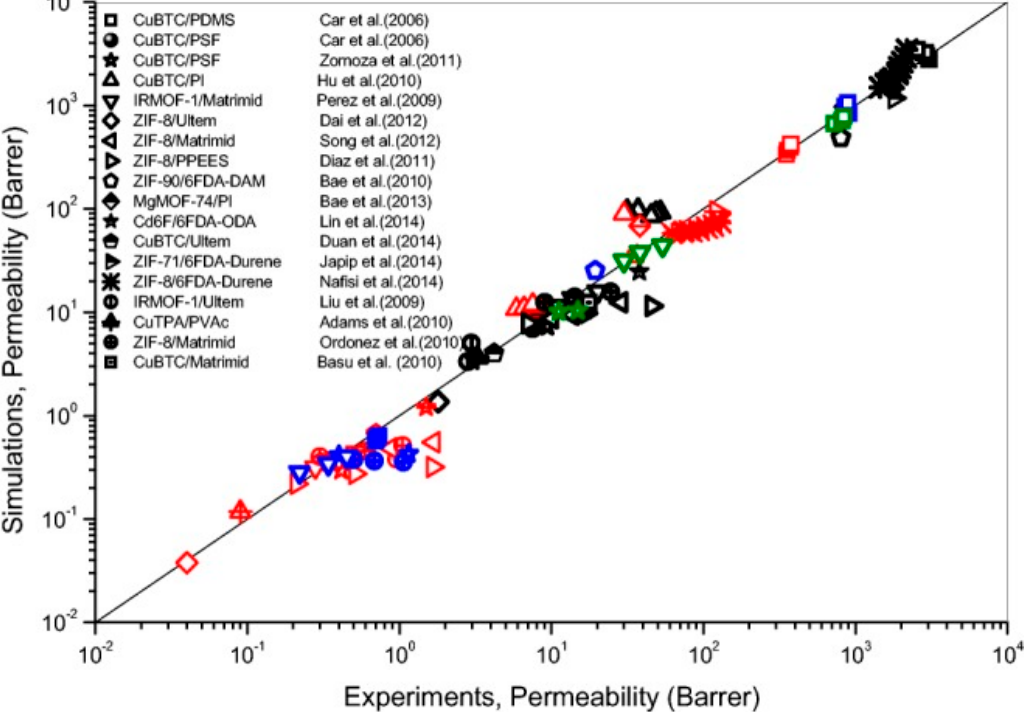
Figure 7. Comparison of our molecular simulation results with experimentally measured H 2 (green), CH 4 (blue), CO 2 (black) and N 2 (red) permeability of MOF ‐ based MMMs. Reprinted from ref. [90] with permission from Wiley.